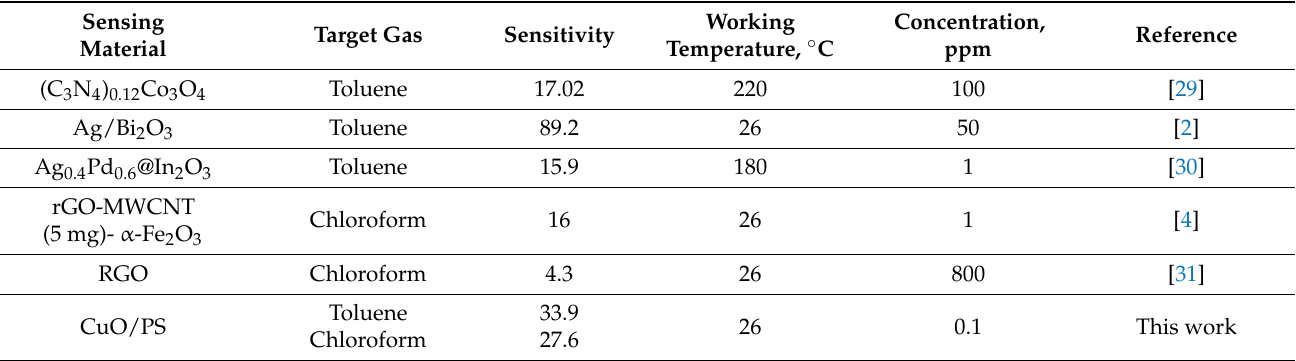
Figure 5. Dynamic response curves of the sensor to 0.1 ppm toluene and chloroform vapors. Table 1. Comparison of toluene and chloroform gas sensors.